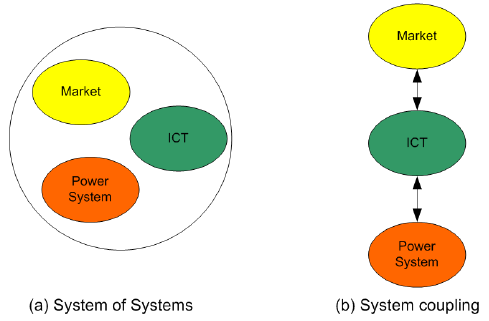
Figure 1. Illustration of different possible topologies in conceptual layer of a CPES co-simulation framework. Table 1. Generic layers of a co-simulation